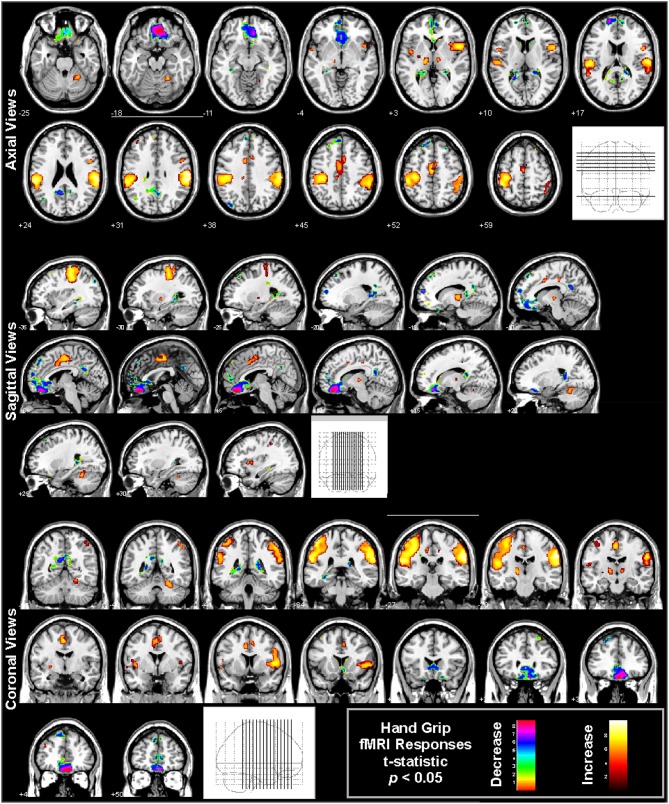
Hand grip fMRI responses in 65 healthy controls (41 male, age mean ± sd [range] = 47.5 ± 8.8 [30.9–65.8] years, 11 left handed). The protocol consists of four 16 s challenges of 80% subjective maximal grip, 1 min apart. Analysis using SPM software with boxcar modeling of significant responses (p < 0.05 t-test, all regions corrected at whole-model F-test level for multiple comparisons at p < 0.05 family-wise error). Regions of signal increases (warm colors) and decreases (cold colors) are overlaid onto multiple views, illustrated the varied regions of response (Data from Harper et al., 2008).